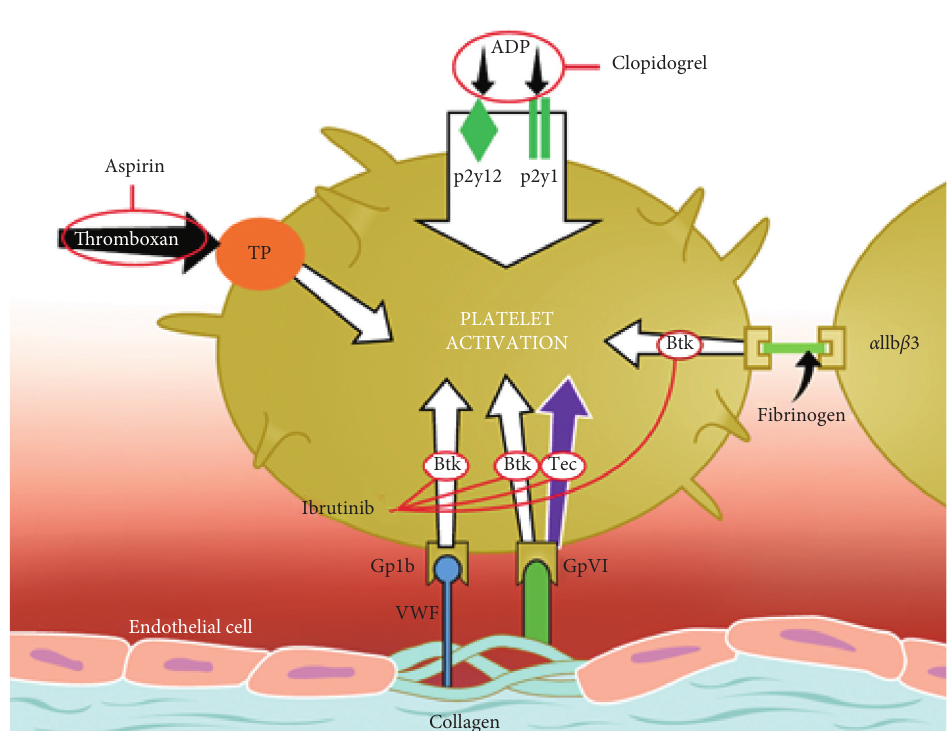
Figure 2: The effects of ibrutinib on platelet function. Btk, Bruton’s tyrosine kinase; Tec, tyrosine kinase expressed in hepatocellular carcinoma; aspirin effects thromboxane A2 receptor (TP); clopidogrel effects adenosine diphosphate (ADP) via p2y12 & p2y1 receptors; von Willebrand factor (VWF) effects glycoprotein Ib (GpIb); collagen binds glycoprotein VI (GpVI); fibrinogen binds integrin α IIb β 3. This work, “The effects of ibrutinib on platelet function,” is a derivative of “The effects of ibrutinib on platelets” by Shatzel et al., retrieved from https://onlinelibrary.wiley.com/doi/full/10.1111/jth.13651. Used under Creative Commons Attribution-NonCommercial 3.0 Unported (CC BY-NC 3.0) Generic license